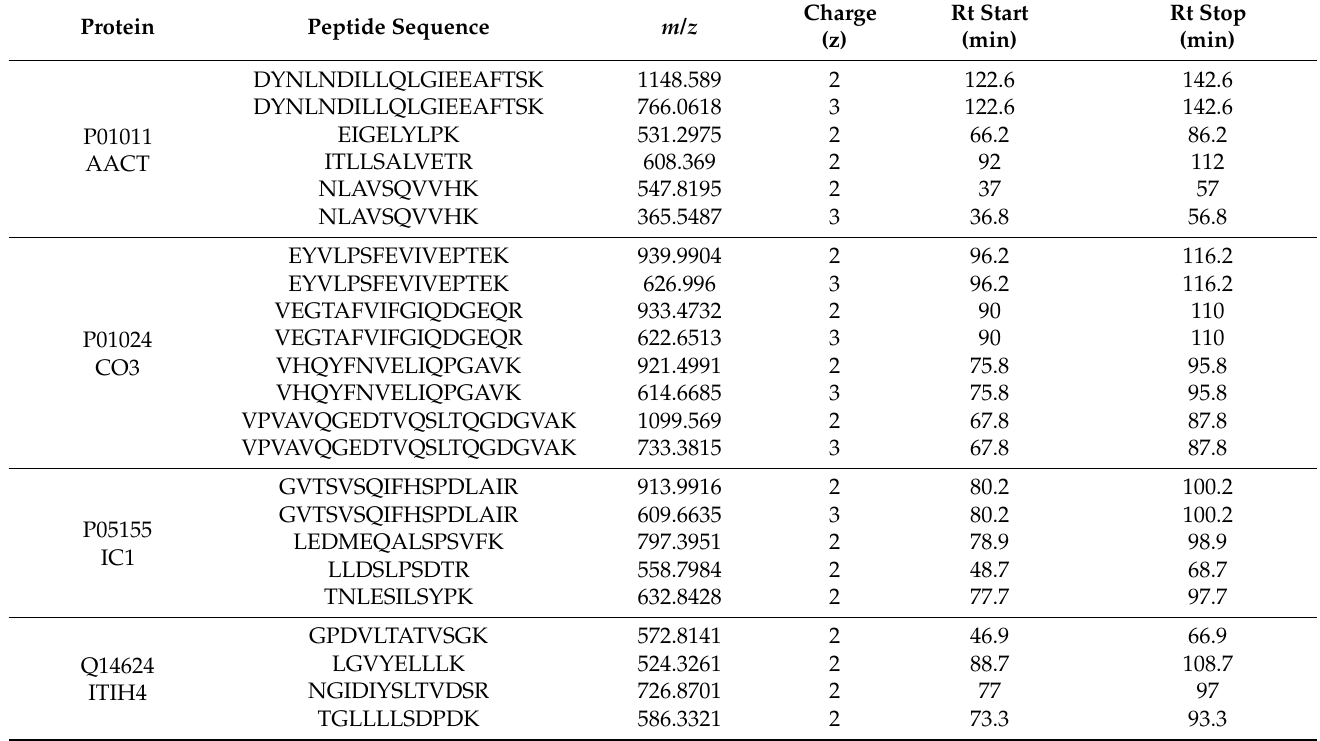
Table 2. Targeted ions for parallel reaction monitoring analysis. Uniprot identifier of each protein, peptide sequence using the standard one-letter code for the amino acids, the mass-to-charge ratio ( m / z ), charge (z), start (Rt start) and stop (Rt stop) retention times (in minutes) are shown. AACT, alpha-1-antichymotrypsin; CO3, complement C3; IC1, plasma protease C1 inhibitor; ITIH4, inter- alpha-trypsin inhibitor heavy chain H4; min,